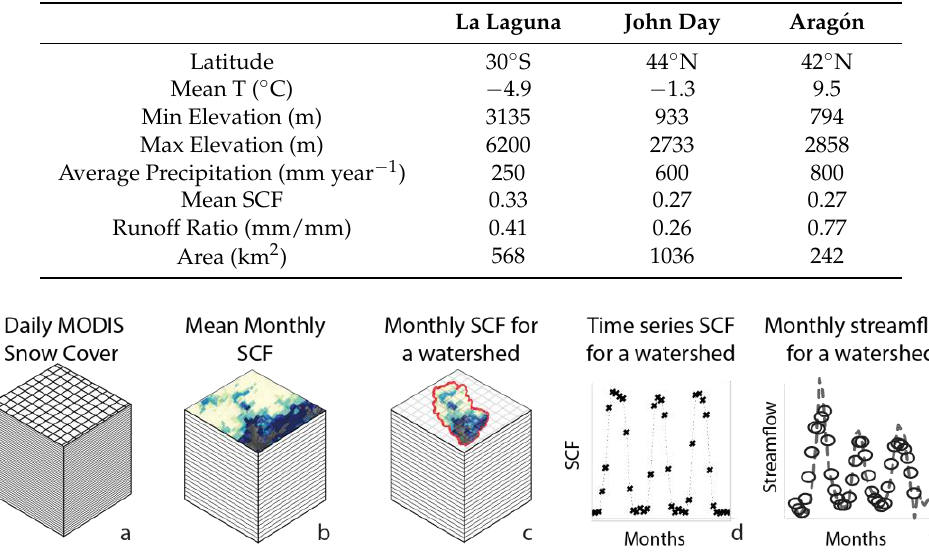
Figure 2. A conceptual flowchart of the SnowCloud framework. ( a – c ) SnowCloudMetrics calculating Snow Cover Frequency (SCF) for a watershed using Moderate Resolution Imaging Spectroradiometer (MODIS) satellite data and is ( d , e ) transitioned into a streamflow forecast using SnowCloudHydro. ( a ) Data arrays and tiling of satellite images are used to ( b ) calculate SCF for each month. ( c ) These monthly data are then spatially subset and averaged by study watershed, and ( d ) converted into a time series for the MODIS record (three years of data shown in this figure). ( e ) The SCF data are then implemented into a streamflow forecast model for the watershed with a one-month lead-time. Here we used SnowCloudMetrics to compute the monthly SCF from the daily MOD10A1 [36] snow cover product at 500-m resolution. For each MODIS pixel, SCF represents the ratio of the number of days in a month that the pixel is snow covered: